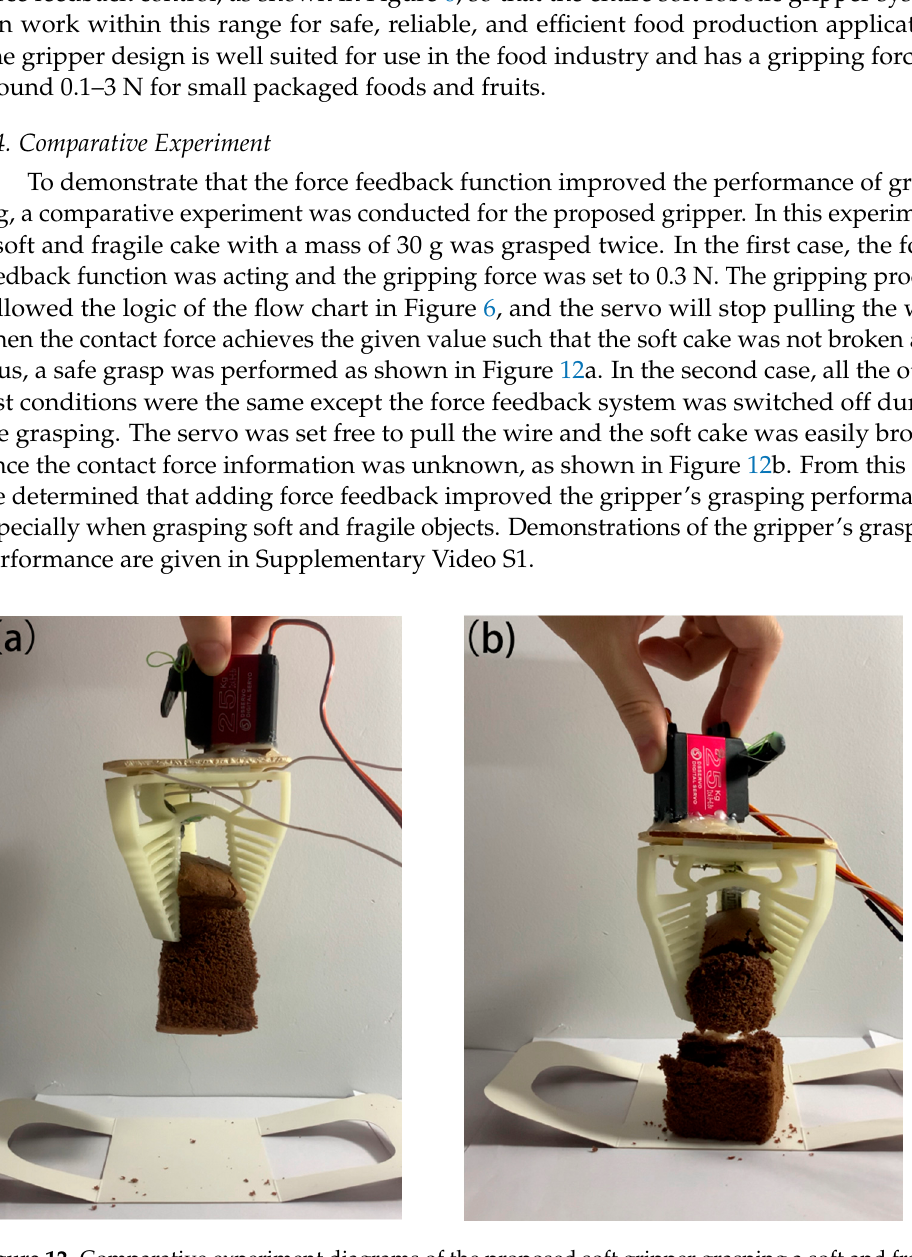
Figure 12. Comparative experiment diagrams of the proposed soft gripper grasping a soft and fragile cake with and without the force feedback function. Force feedback in action ( a ), force feedback not in action ( b ).